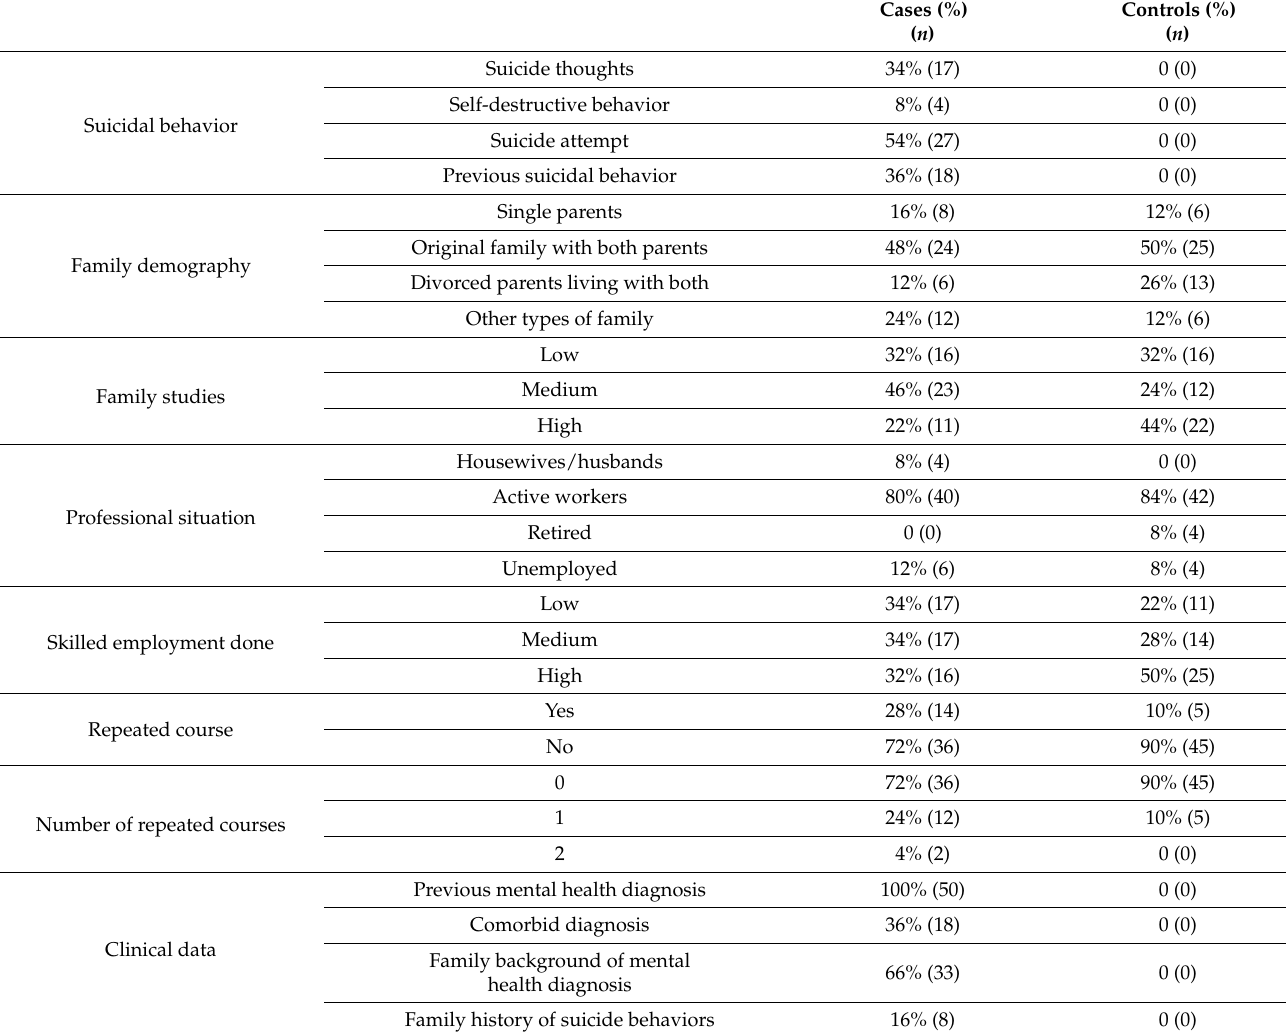
Table 1. Clinical characteristics of the sample ( N =